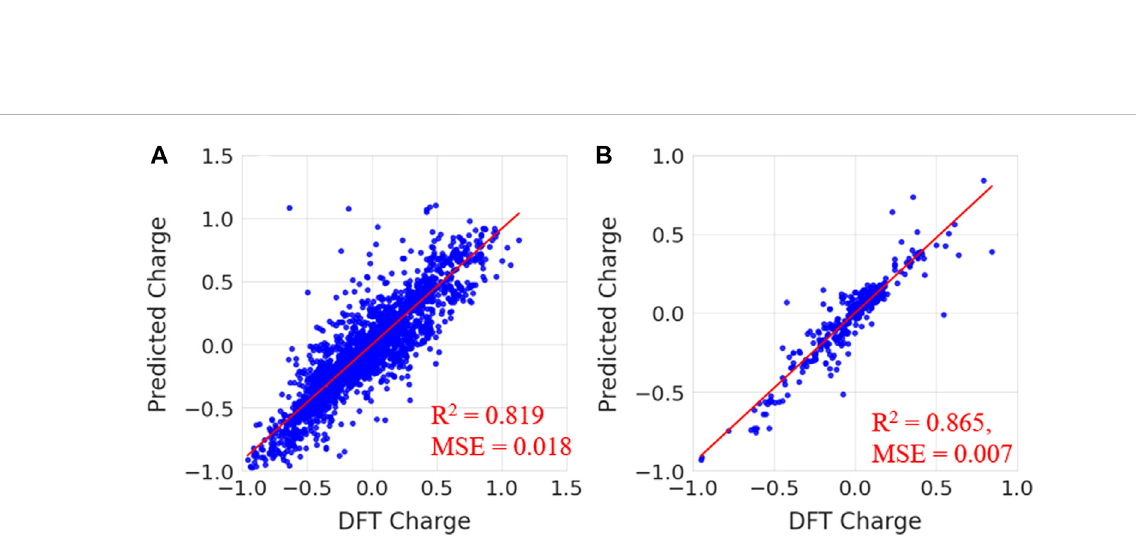
FIGURE 9 Predicted charges vs. DFT charges for (A) test set-1 from the drug-induced liver injury database and (B) test set-2 for known small